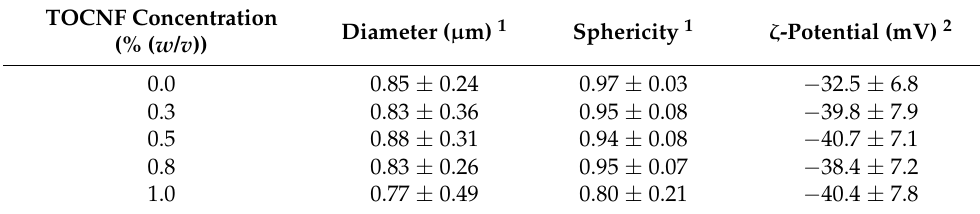
Figure 5. FTIR spectra of MPs synthesized with different concentrations of TOCNF: ( a ) 0% ( w / v ), ( b ) 0.3% ( w / v ), ( c ) 0.5% ( w / v ), ( d ) 0.8% ( w / v ), and ( e ) TOCNF used. Table 1. Diameter, sphericity index, and ζ -potential of TOCNF–DHP